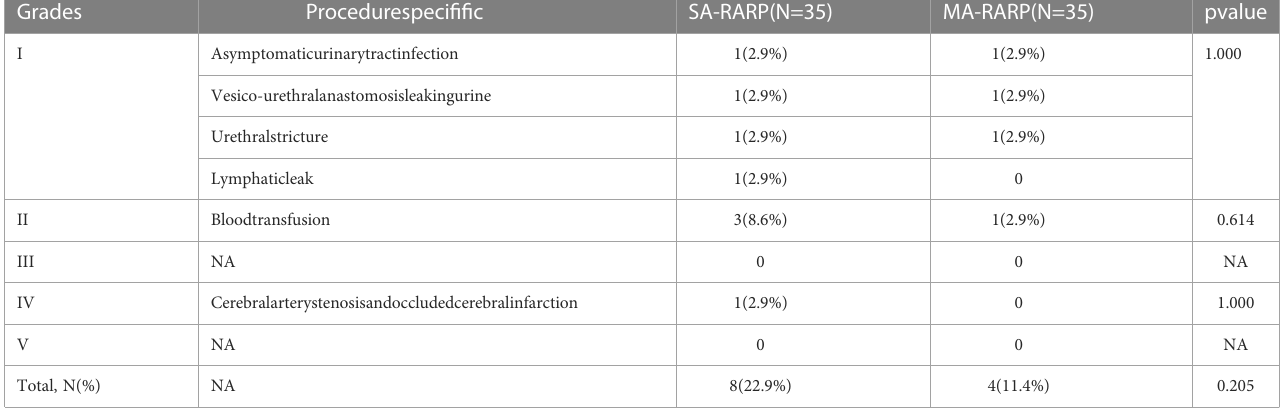
TABLE 2 Procedure speci fifi c complications, strati fifi ed by Clavien-Dindo classi fifi cation in 35 men treated with MA-RARP and 35 treated with SA-RARP.